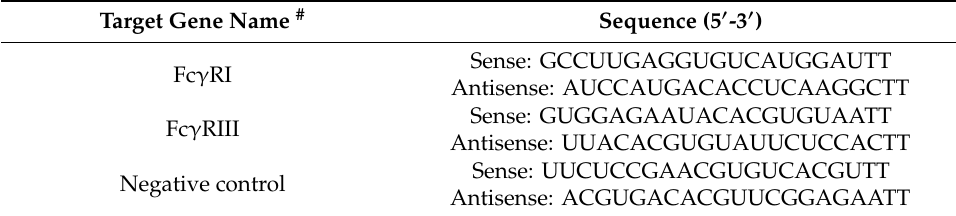
Table 1. Small interfering RNAs (siRNAs) used in this